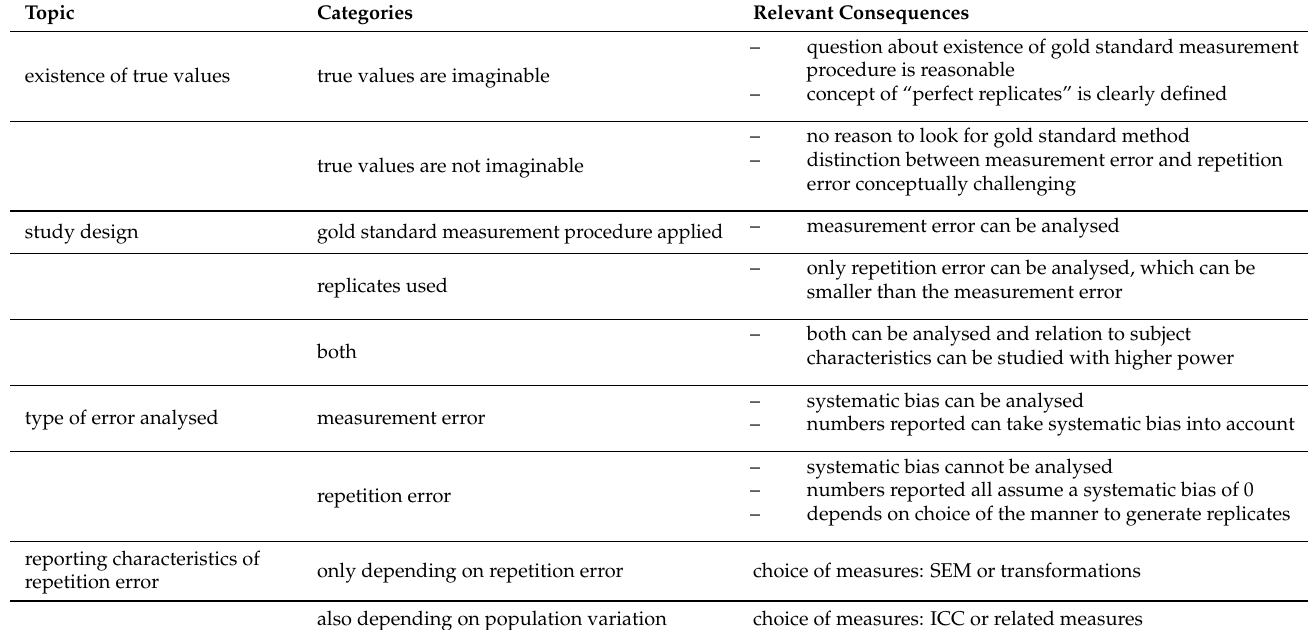
Table 2. Four relevant distinctions in communication about systematic investigations of the measurement error of a measurement